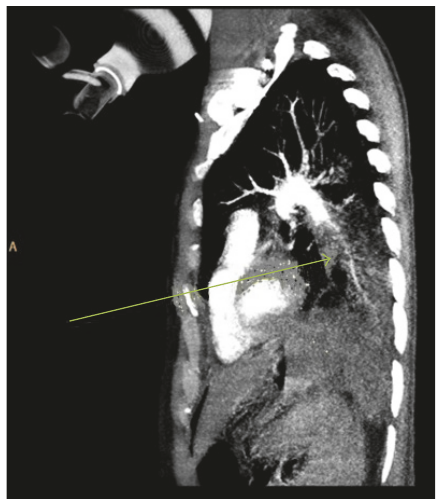
Figure 3: Left parasagittal contrast enhanced computed tomog- raphy pulmonary angiography. The arrow points to a large filling defect (pulmonary embolus) in the left pulmonary